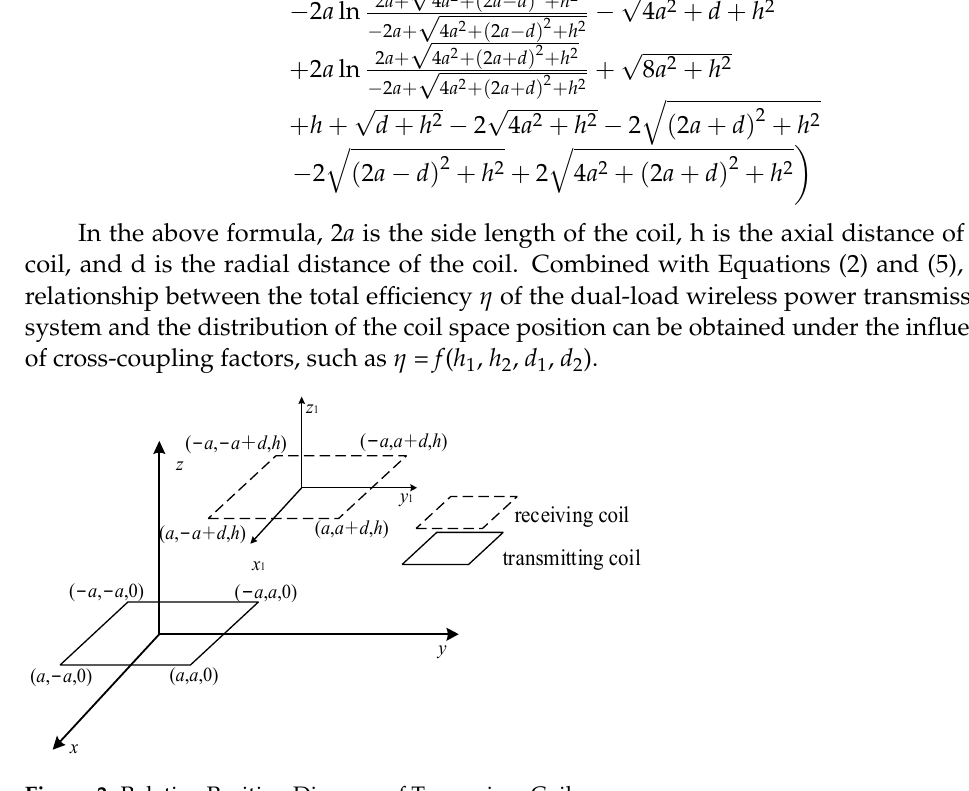
termined by mutual inductance. According to Figure 3 and combined with electromag- netic field theory, the analytical formula of mutual inductance between coils at any posi- tion in space can be obtained: